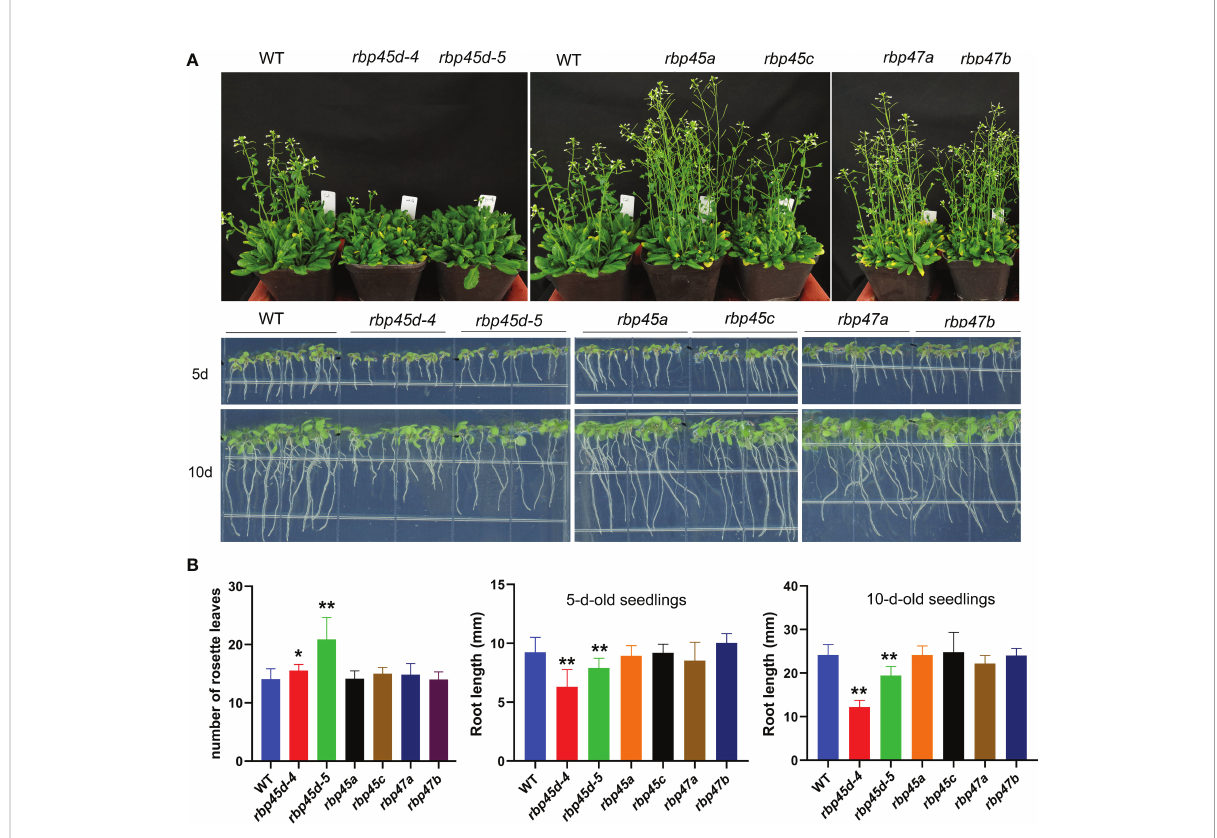
FIGURE 4 RBP45d promote fl owering and root growth that different from other RBP45/47 members. (A) Phenotypic comparison among rbp45/47 mutants. The upper panel shows the phenotype of 45d-old rbp45/47 mutants grown under LD conditions (16h light/8h dark photoperiod). The lower panel shows 5-d- and 10-d-old rbp45/47 mutants vertically grown on 1/2 MS plates. (B) The left panel shows the rosette leaf number of each genotype at bolting in LD conditions. The middle and right panels show root length of 5-d and 10-d-old seedlings, respectively. The data are shown means ± SD (n = 20). Student ’ s t -test, * P < 0.05, ** P < 0.01, compared to WT. The experiments were performed at least three